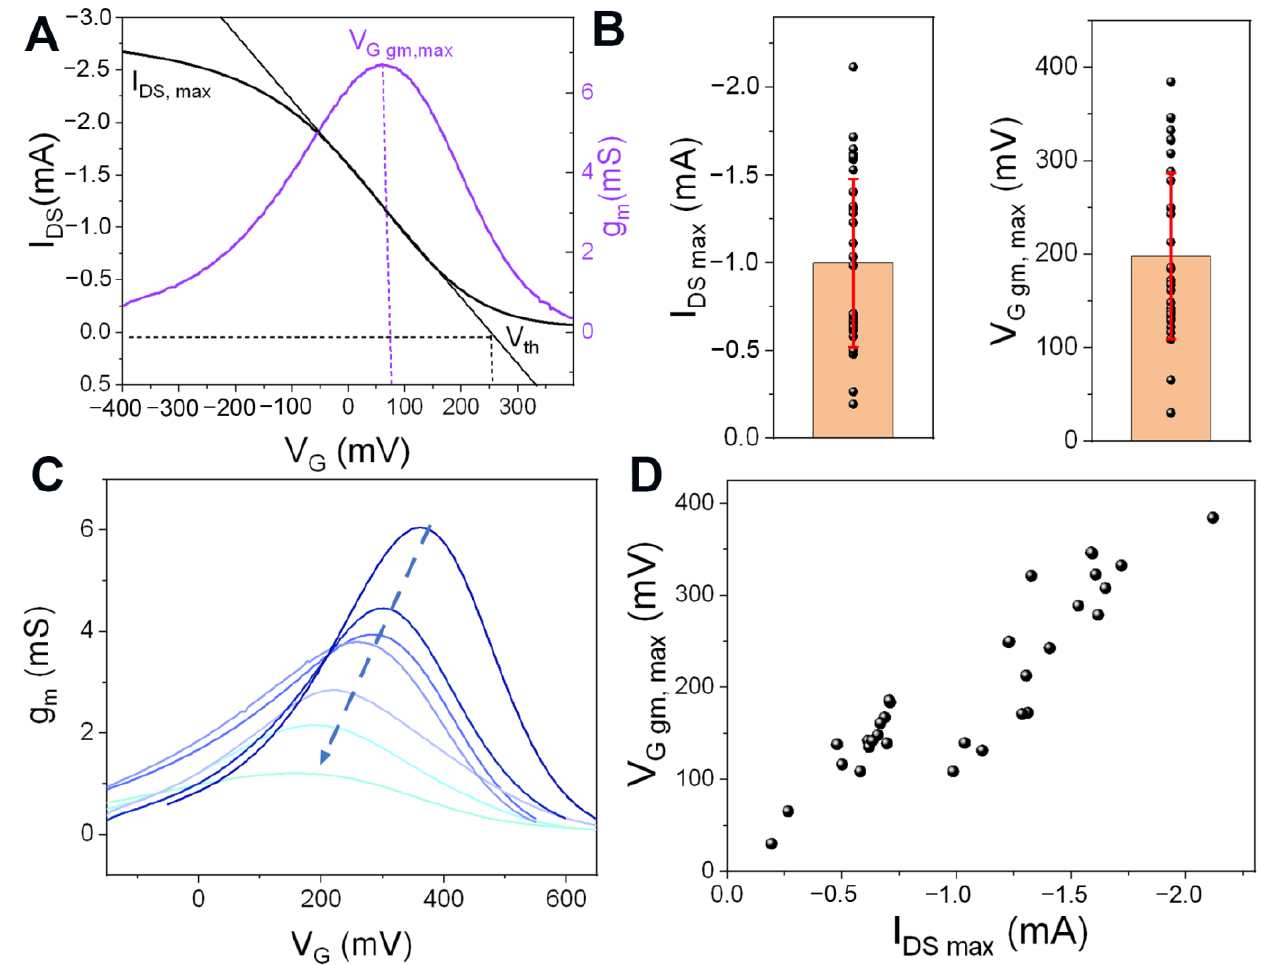
Figure 2. ( A ) Characteristic transfer curve and transconductance as a function of the gate potential for a PEDOT-PAH-based OECT. ( B ) I DS max and V G gm, max for 30 different OECTs synthesized in the same conditions. Bars represent the mean values, and the error bars are the SD. ( C ) g m vs. V G for seven representative OECTs (arrow indicates decreasing transconductance values corresponding to thinner films). ( D ) V G gm, max as a function of I DS max for different PEDOT-PAH-based OECTs. (KCl 10 mM + HEPES 1 mM, V DS = − 50